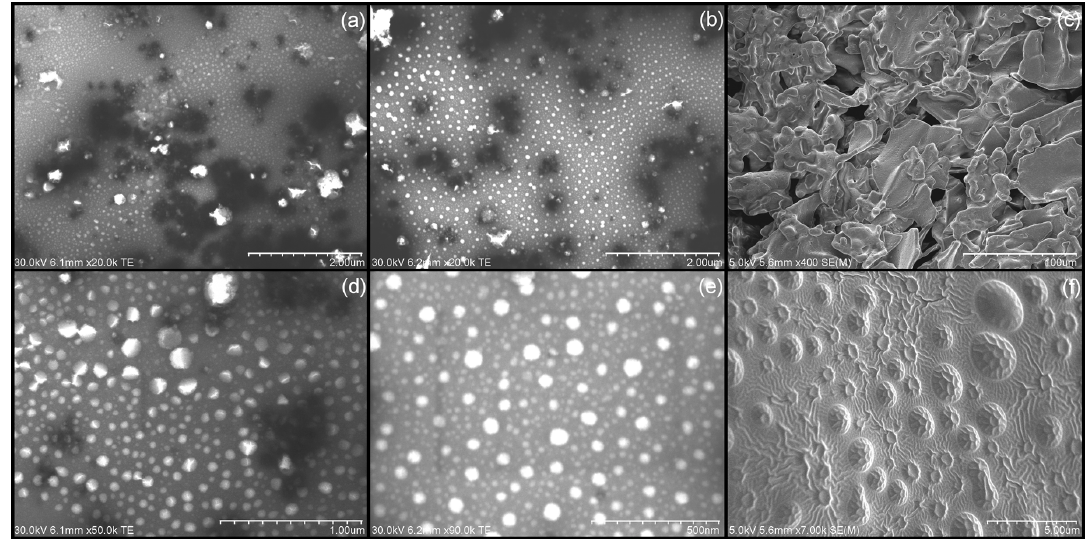
Figure 1. Scanning electron microscopy (SEM) micrographs of liquid γ -tocotrienol nanoemulsion (GT3 NE) ( a ) low magnification; ( d ) high magnification; reconstituted lyophilized GT3 NE ( b ) low